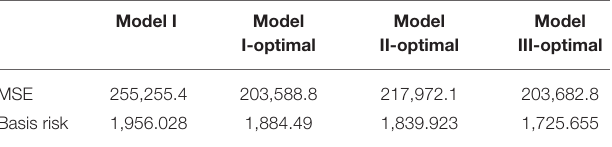
TABLE 6 | The basis risk of the representative contract portfolio. TABLE 7 | The “false positive” and “false negative” basis risk of the representative contract